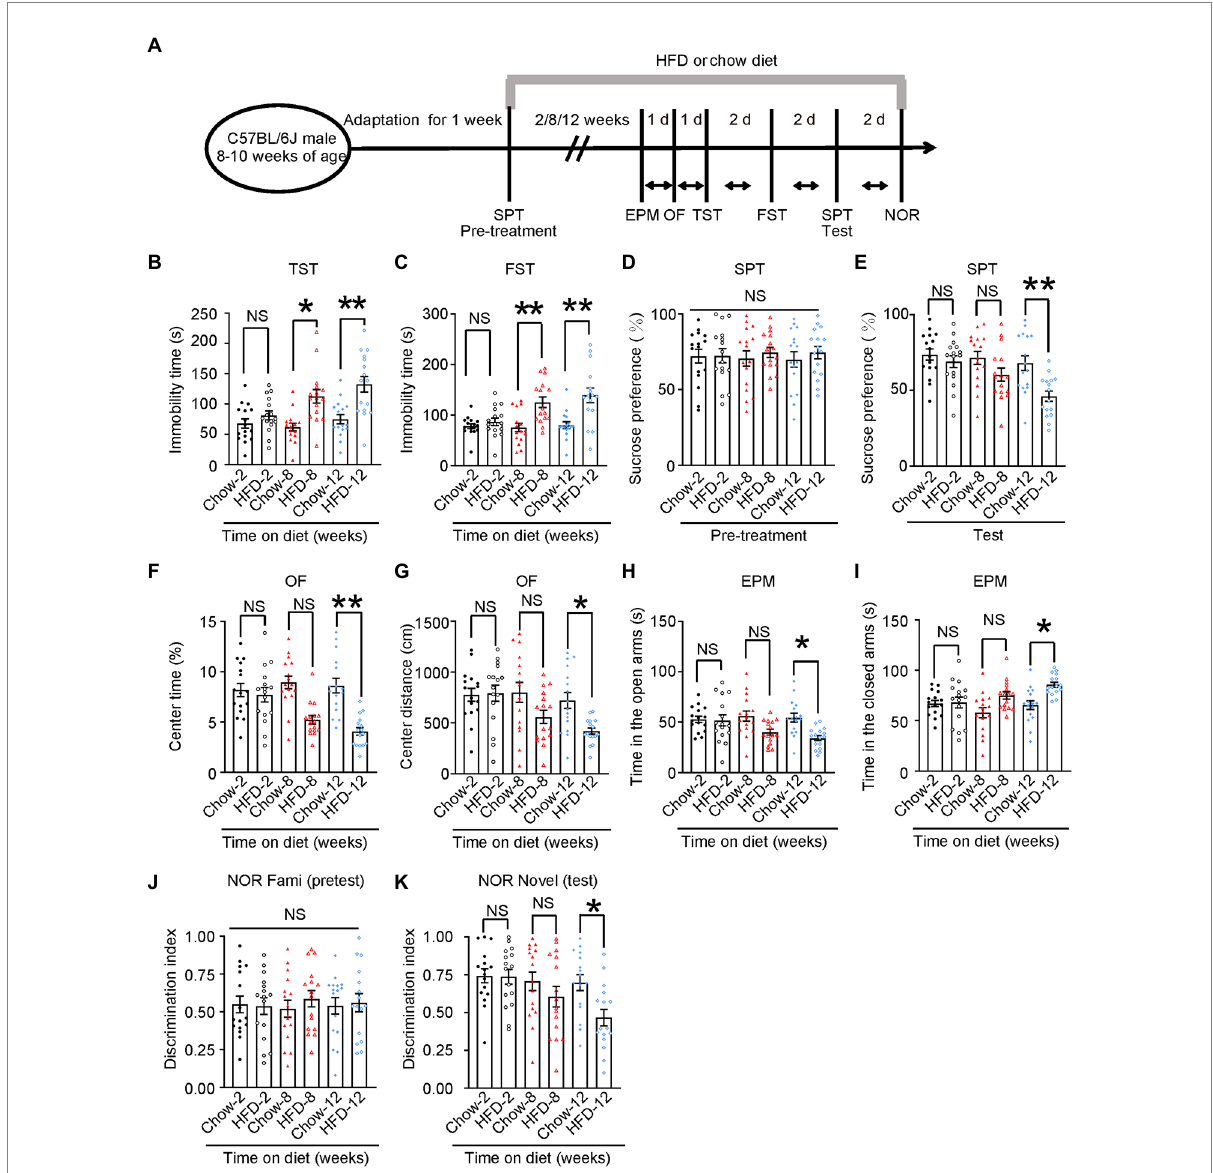
FIGURE 1 HFD induces depression-like behaviors. (A) Schematic of the HFD or chow diet course and behavioral tests plan. HFD, high-fat diet; TST, tail suspension test; FST, forced swim test; SPT, sucrose preference test; d, day. (B) Tail suspension test, (C) forced swim test, (D,E) sucrose preference test, (F,G) open-field test, (H,I) elevated plus maze test, and (J,K) novelty object recognition test results. Experiments were conducted on 8–10-week-old C57BL/6 J male mice fed with a chow diet or HFD for 2, 8, or 12 weeks. Results are presented as the mean ± SEM ( n = 16 mice for each group; * p < 0.05; ** p < 0.01; NS, not significant; one-way ANOVA and Bonferroni’s multiple comparison